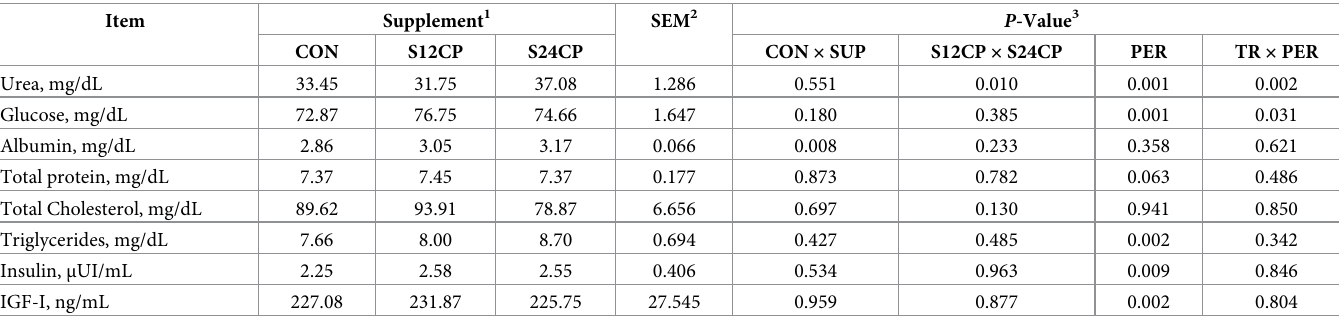
Table 5. Blood parameters of Holstein x Gyr crossbred heifers on a rotational grazing system Panicum maximum cv. Mombac¸a pasture.